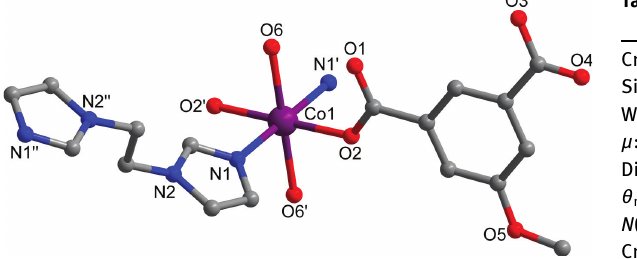
Table 1: Data collection and